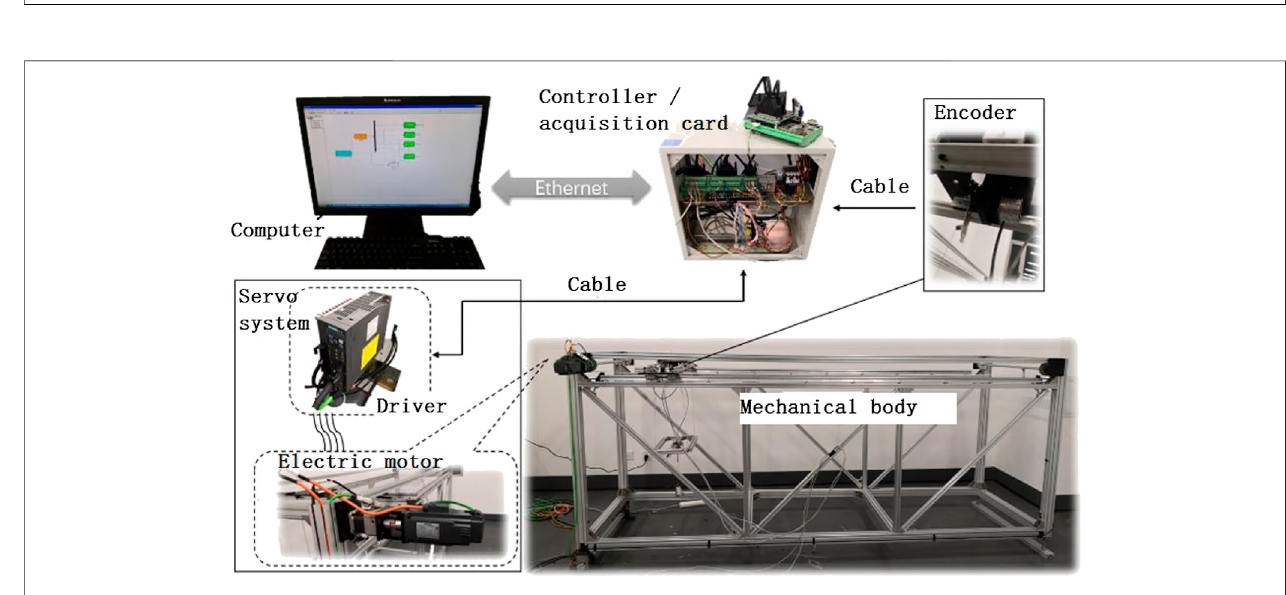
FIGURE 5 | Neural network compensation control system response to phase trajectory.